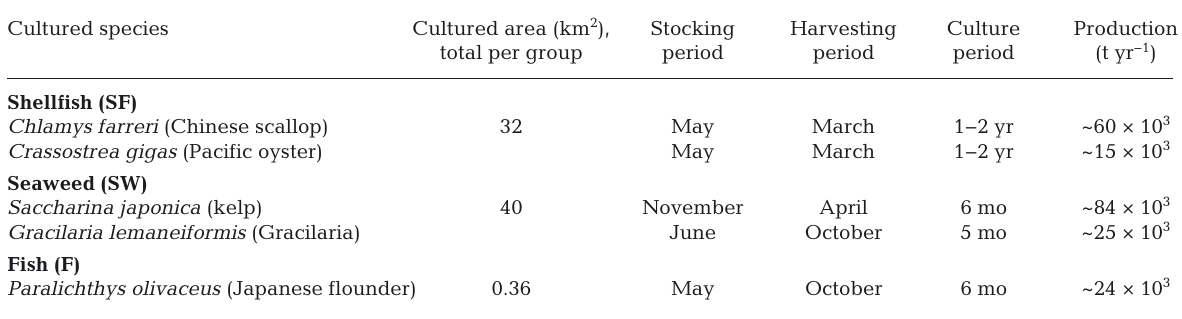
Table 1. Summary of aquaculture in Sanggou Bay, where species are cultured in combination (SF+F, SF+SW) and monocul- ture (SW) in integrated multi-trophic aquaculture (IMTA). Additional details on the cultured area, annual production, and stocking, harvesting and culture periods for the different groups are also given (data from Zhao et al. 1996, Ferreira et al. 2007, Rongcheng Fisheries Technology Extension Station 2012 statistics